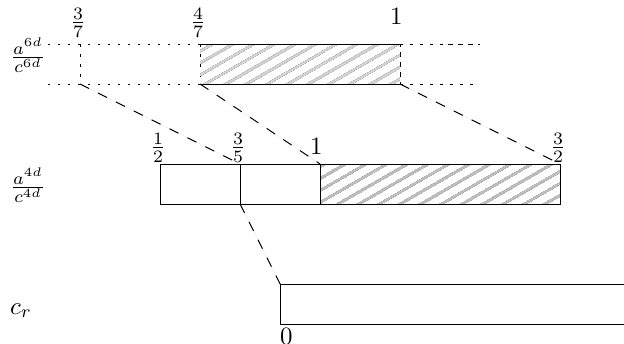
Figure 1 . Mapping of various values of a=c under (3.13) from 6d N = (2 ; 0) to a 4d N = 1 theory, as well as the flow from 4d to 2d obeying (3.24) and preserving N = (0 ; 2) supersymmetry. Positivity of c r in 2d is mapped into the lower bound 3 = 7 in 6d.